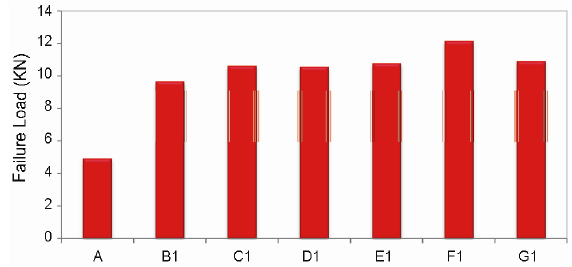
Fig. 22. Average ultimate failure loads of different groups of specimens with one layer of GFRP